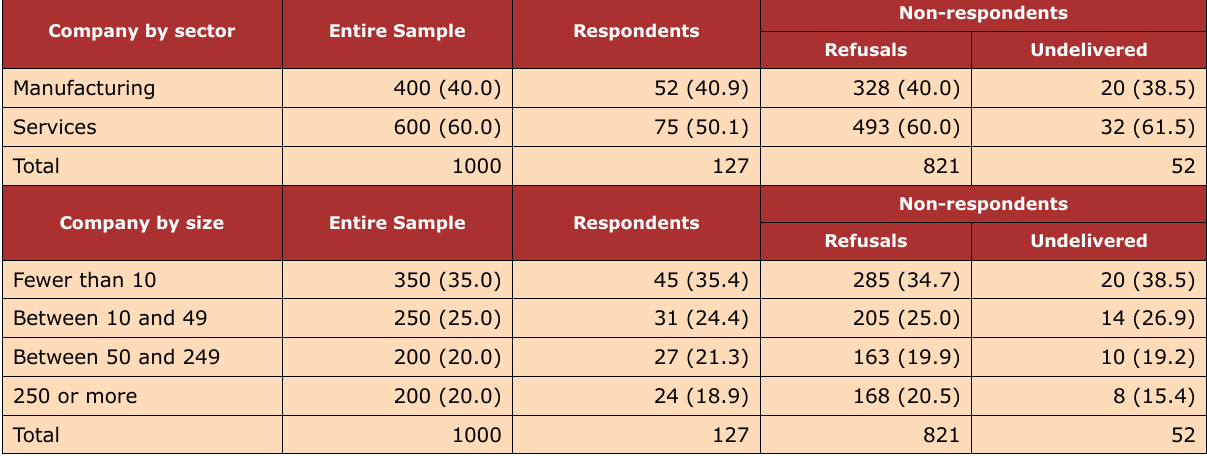
Table 7. Differences of respondents VS